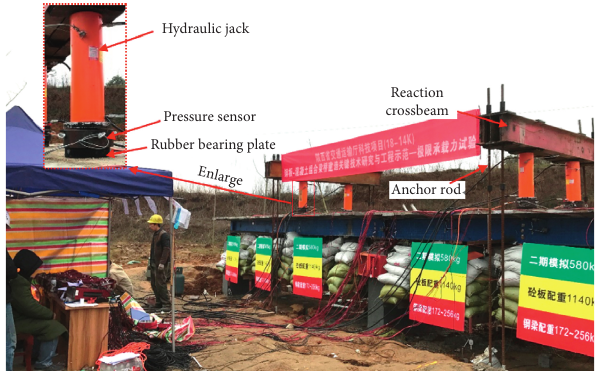
Figure 5: The test loading condition and setup.